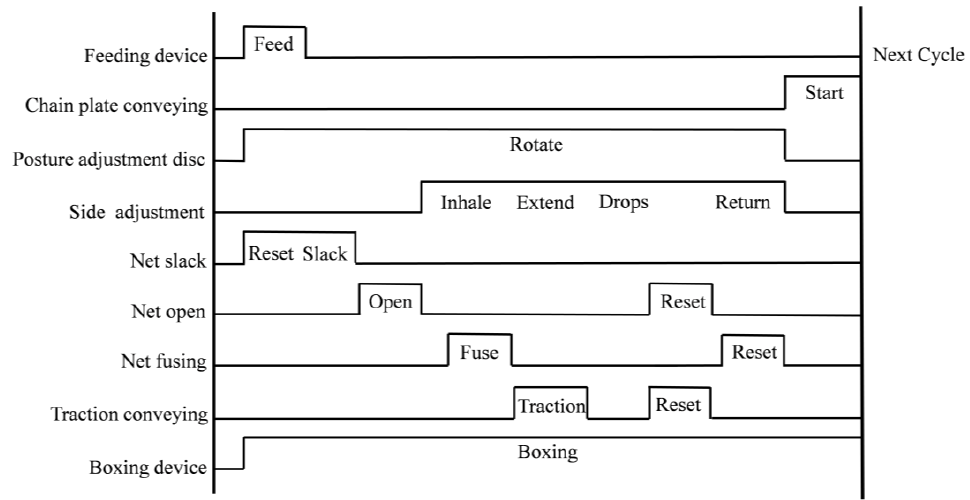
Figure 21. Control Timing Chart.